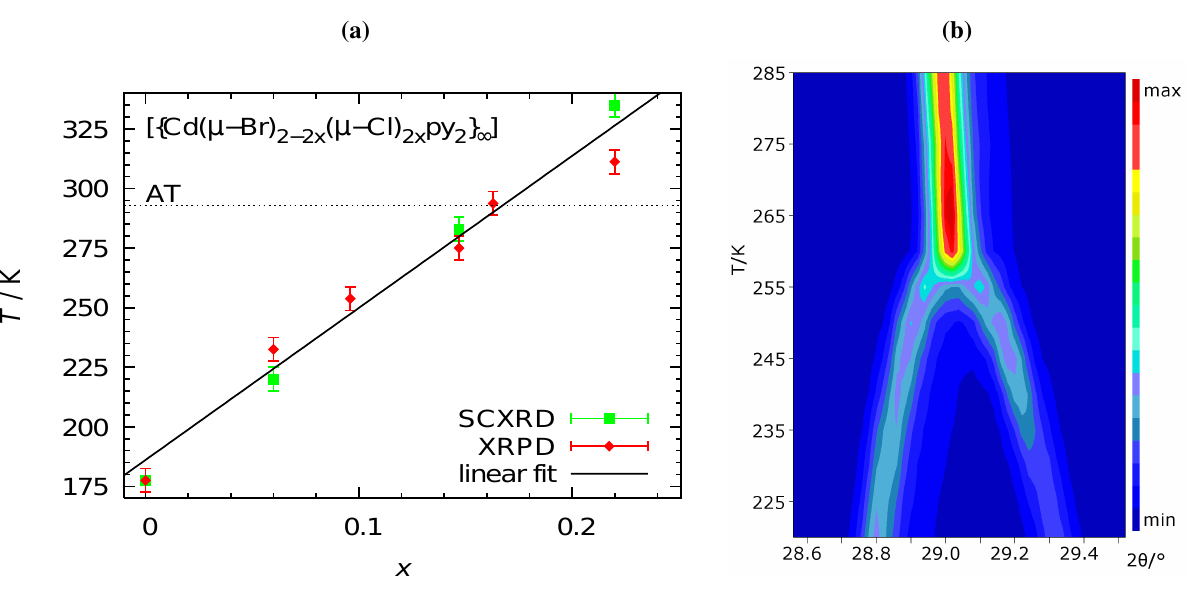
Figure 4. (a) : Dependence of the transition temperature determined by single-crystal X-ray diffraction (SCXRD) and X-ray powder diffraction (XRPD) on the chemical composition determined by ion chromatography. (b) : 2D-plot example from 1 10 of temperature dependent XRPD measurements showing splitting of the orthorhombic 3 1 1 reflection to the monoclinic 3 1 1 and 3 1 ¯1 reflections at transition